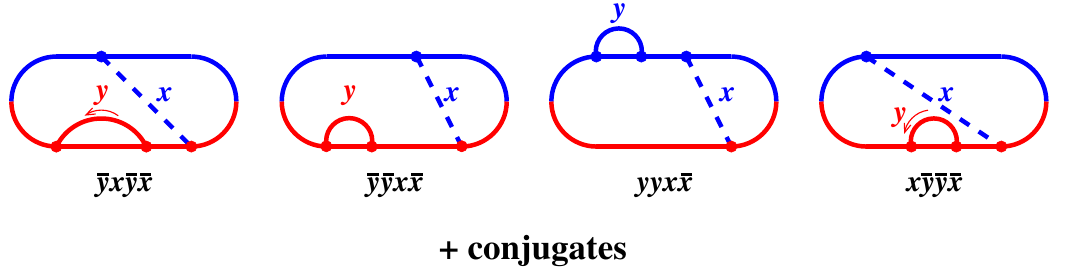
Figure 4 . Class I one-loop virtual corrections to (cid:12)gure 3. As with previous (cid:12)gures, not all possible time orderings of the diagrams have been shown explicitly but the missing orderings are all included when one adds in the complex conjugates (\+ conjugates") of the diagrams explicitly shown above. Graphically, taking the conjugate (cid:13)ips a diagram about its horizontal axis while swapping the colors red and blue.